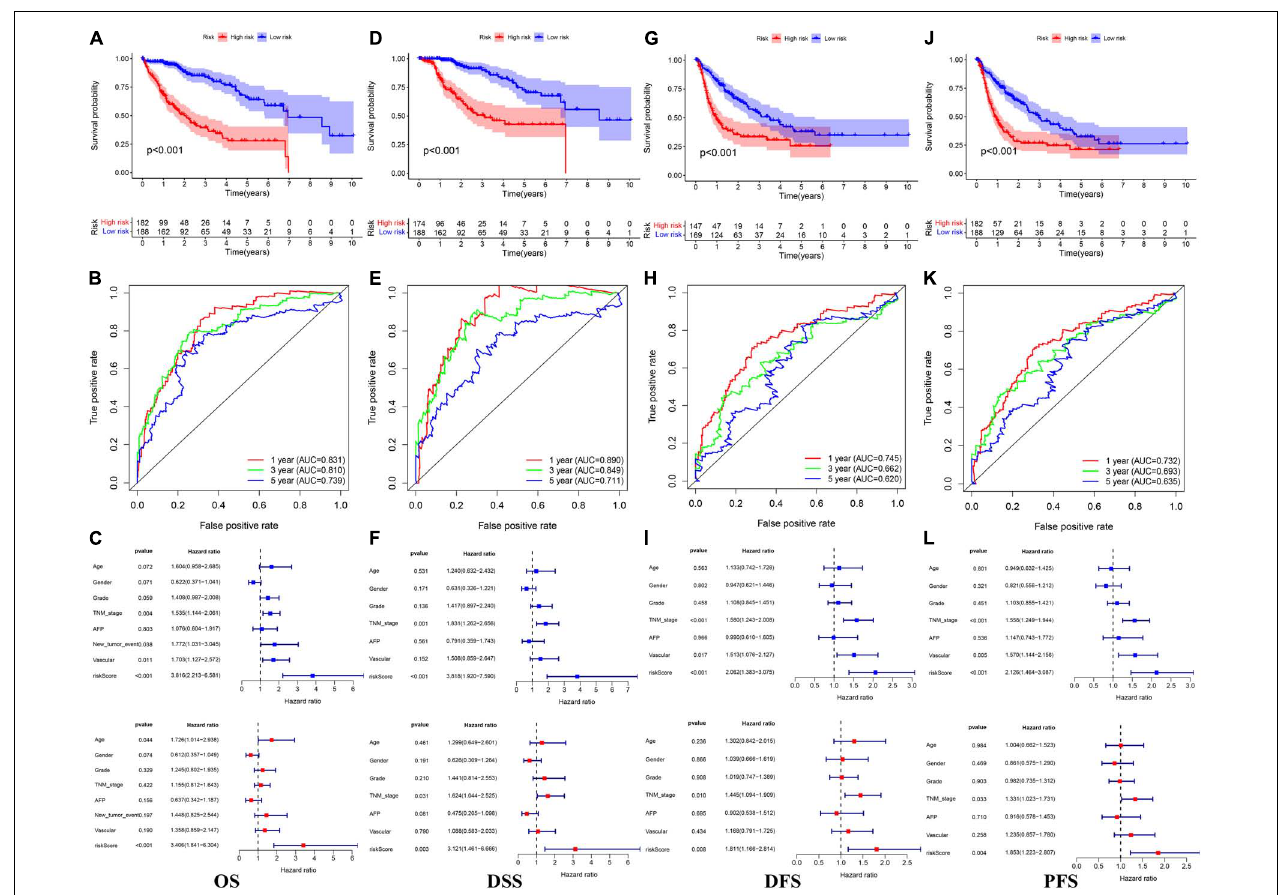
FIGURE 4 | The Kaplan–Meier survival analysis, the time-dependent ROC analysis, and the Cox analysis of the risk score in the TCGA cohort (A–C) OS, (D–F) DSS, (G–I) DFS, and (J–L) PFS. *For (C,F,I,L) blue represents univariate Cox analysis, red represent multivariate Cox analysis.